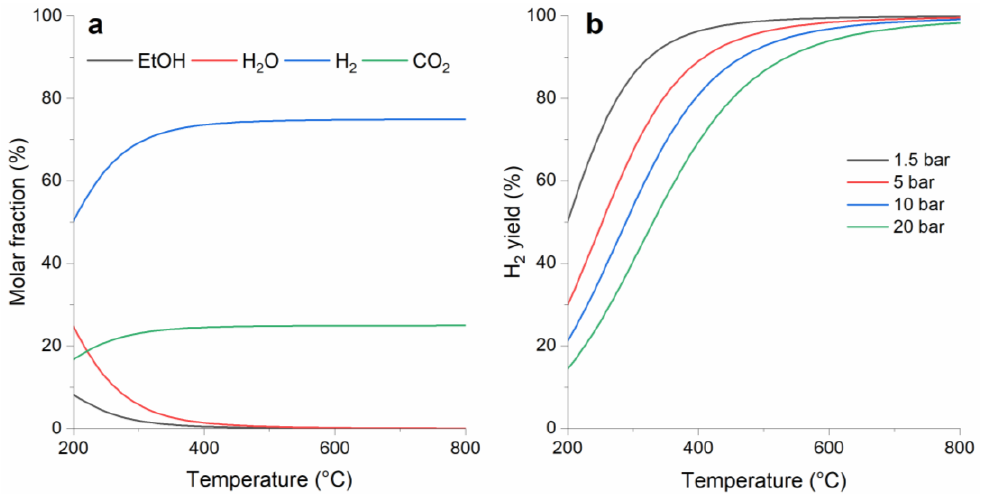
Figure 1. ESR equilibrium composition, considering only the components in reaction (1): ( a ) effect of temperature on equilibrium mixture at 1.5 bar and ( b ) thermodynamic hydrogen fractional yield at different temperatures and pressures. The equilibrium was calculated via Gibbs free energy minimization.